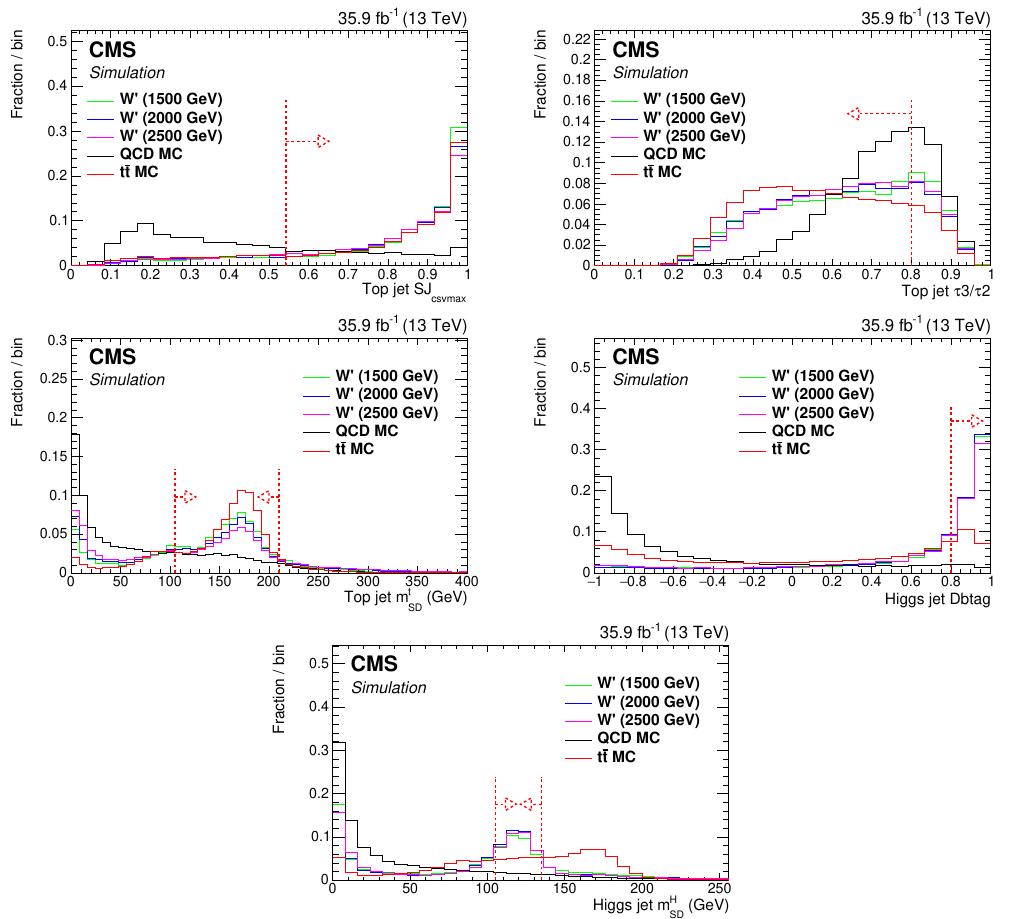
Figure 3 . Normalized distributions of the discriminating variables in tt, QCD, and signal MC simulation. The distributions shown, from upper left to lower right, are of the variables: the maximum subjet b tag, (cid:28) 3 / (cid:28) 2 , and m t , all used for top quark discrimination, and the double-b SD tag discriminant and m H used for tagging candidate Higgs boson jets. The QCD distributions SD are extracted from events with the generator-level H T > 1 TeV. Each variable distribution in